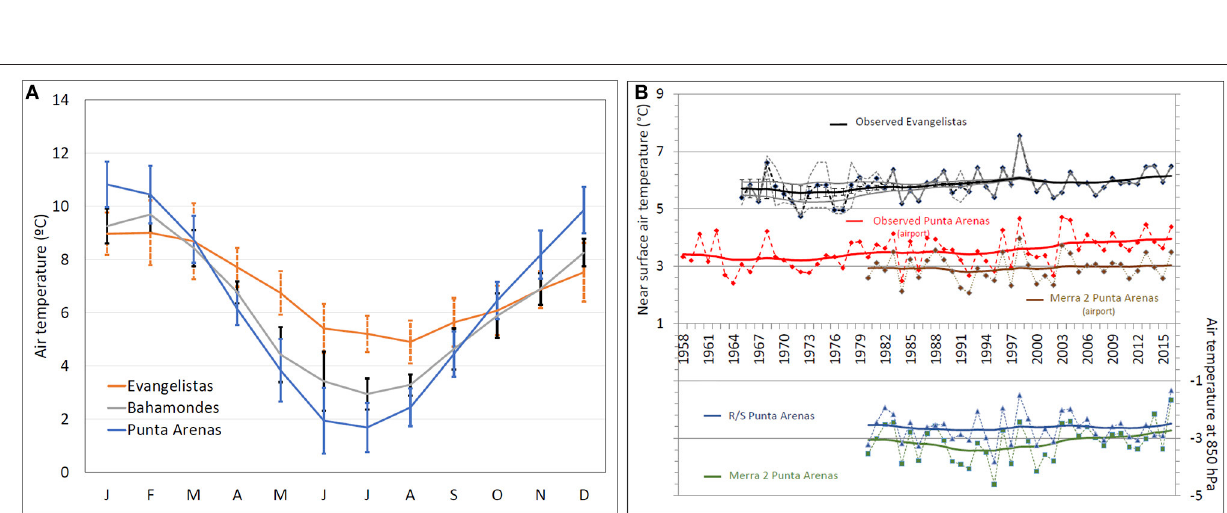
Frontiers in Earth Science | www.frontiersin.org